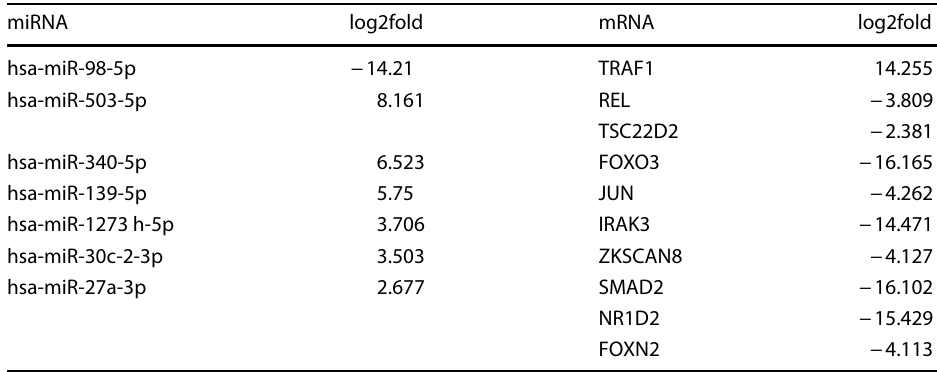
Table 5 List of correlated miRNA and mRNA transcripts observed in OS-P compared to